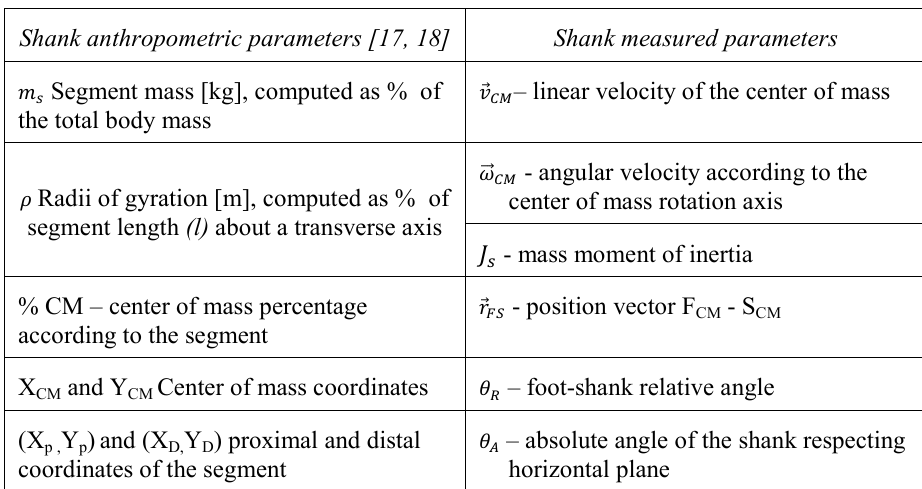
Table 1 . Parameters used for analytical modeling .